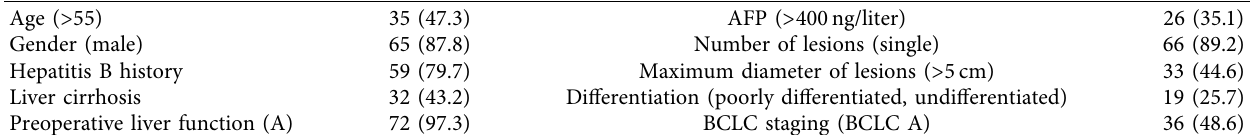
Table 2: Basic information on the enrolled patients (cases (%)).